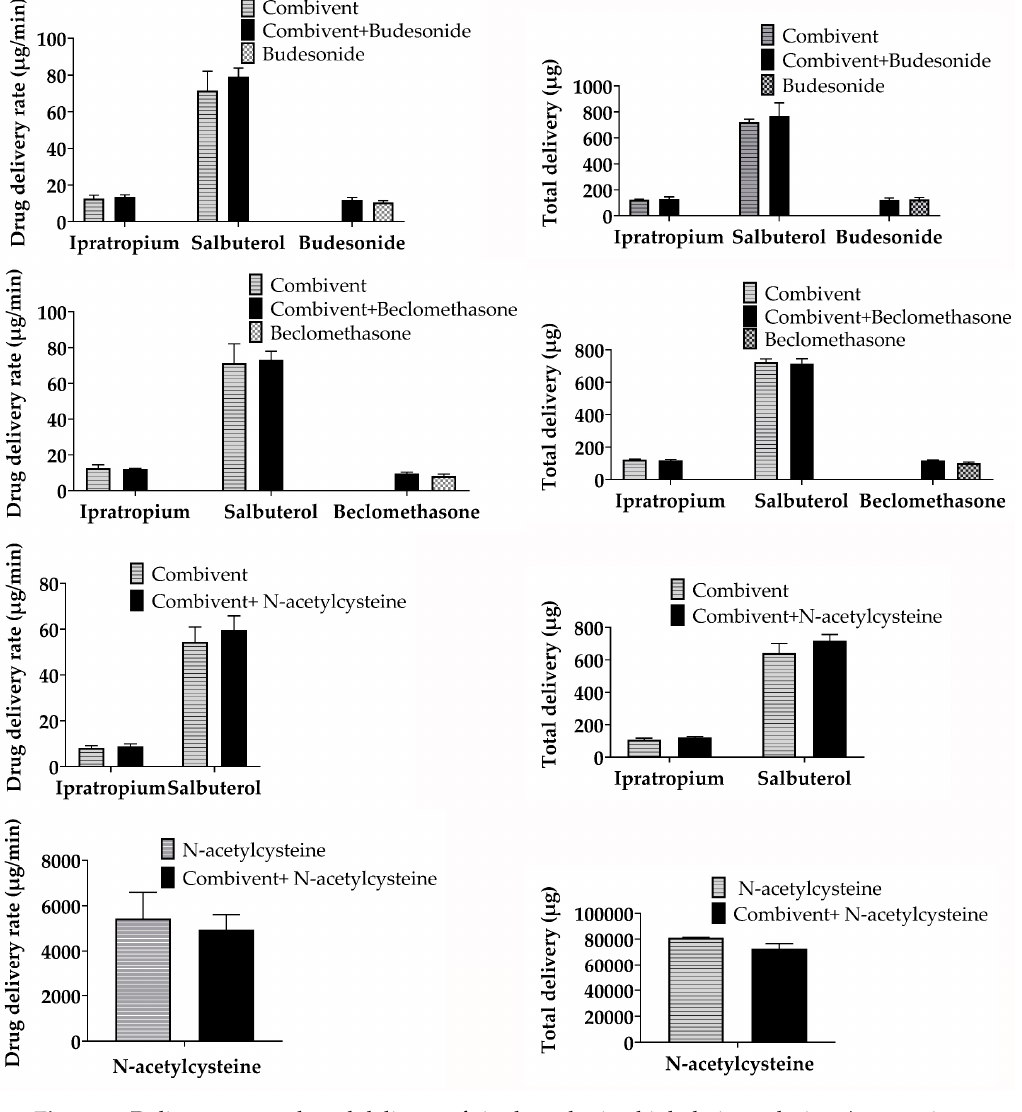
Figure 3. Delivery rate and total delivery of single and mixed inhalation solutions /